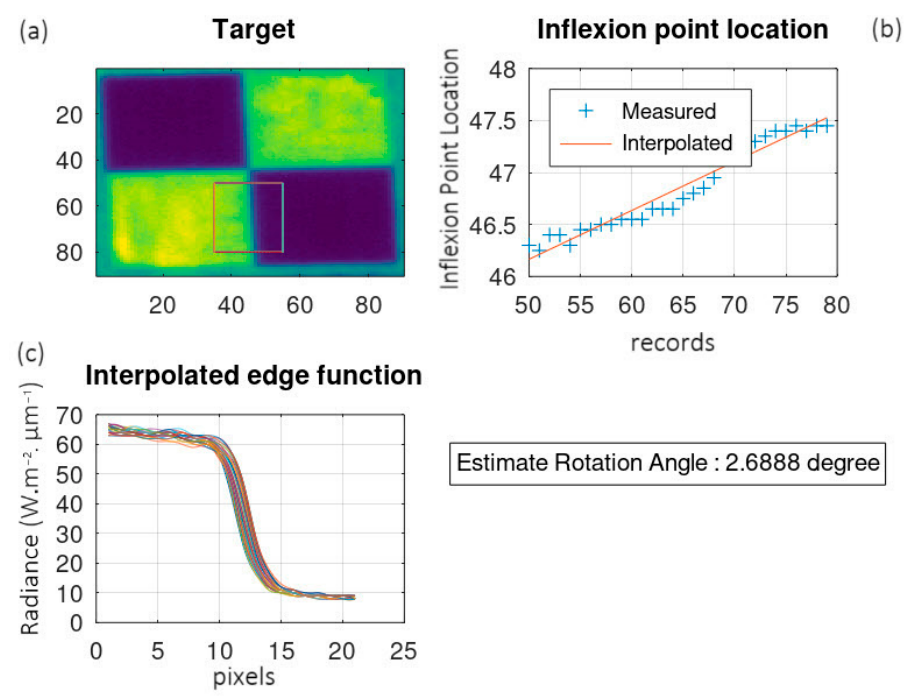
Figure 3. Slant-edge method—edge modeling output: ( a ) the MTF target and the selected image area (red rectangle) for the ESF analysis; ( b ) the line fitting output; and ( c ) the interpolated edges.